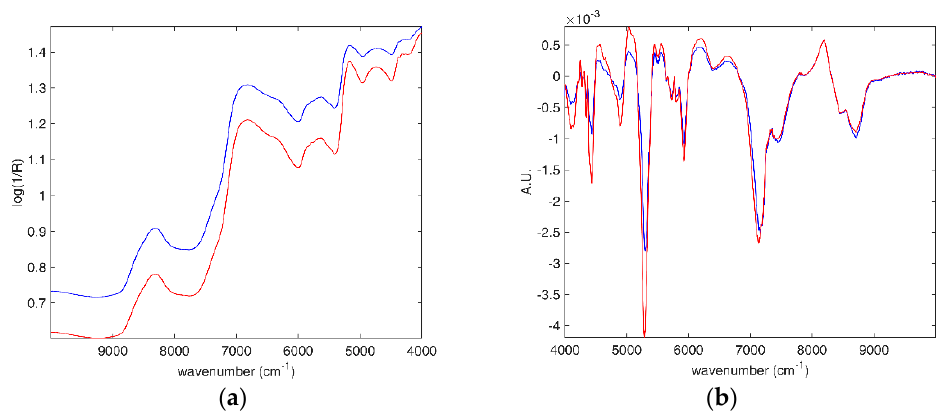
Figure 1. ( a ) Average raw spectra and ( b ) average spectra after the 1 st derivative. Legend: “Class Conformant”: blue line and “Class Adulterated”: red line.